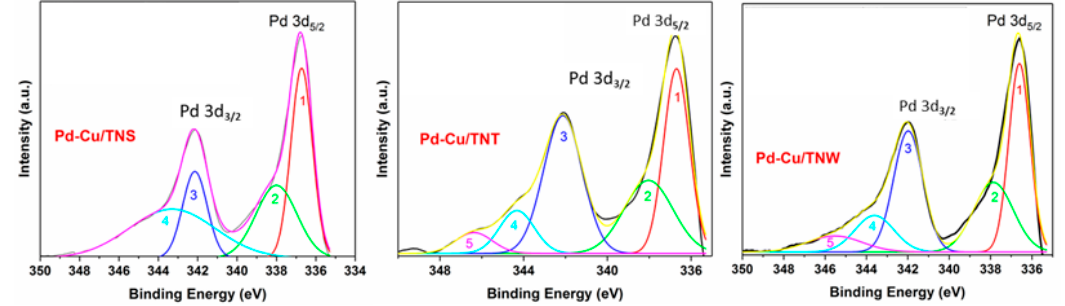
Figure 5. Peak deconvolution for Pd 3d for Pd-Cu/TNS, Pd-Cu/TNT, and Pd-Cu/TNW.